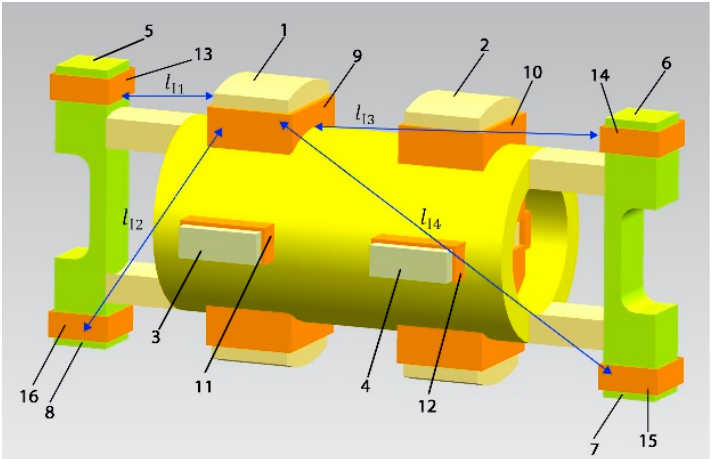
of sleeve,(b) Force diagram of sensor. Figure 9. Structure diagram of piezomagnetic sensor. 1. Vertical excitation core I; 2. Vertical excita-